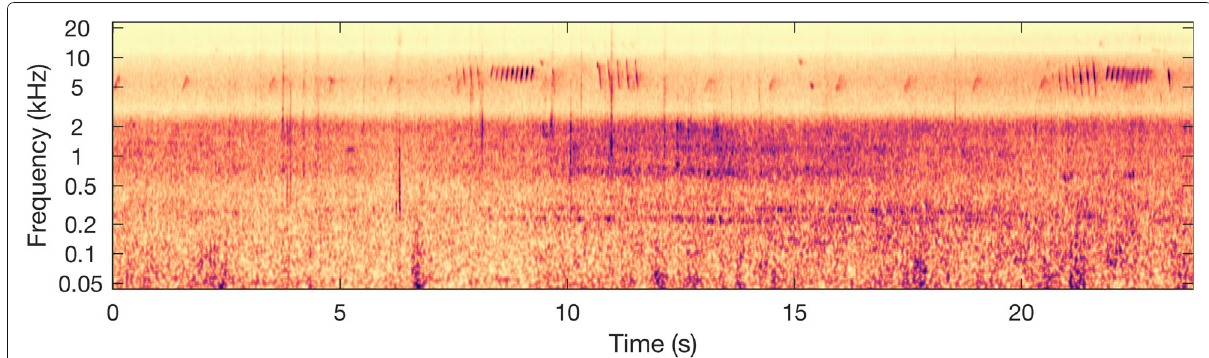
Fig. 3 Wavelet scalogram x 1 ( t , γ 1 ) of the audio recording park04 in the DCASE 2013 dataset. We observe that this acoustic scene is a mixture of transient events (chirping birds, footsteps) and stationary texture (flowing water)